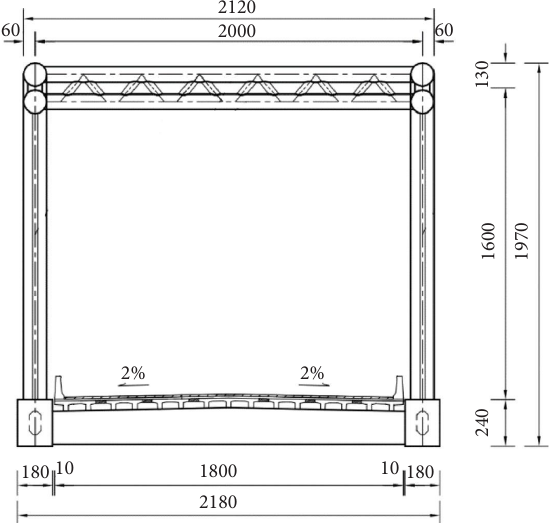
Figure 1: Cross-sectional diagrams of the analyzed bridge.